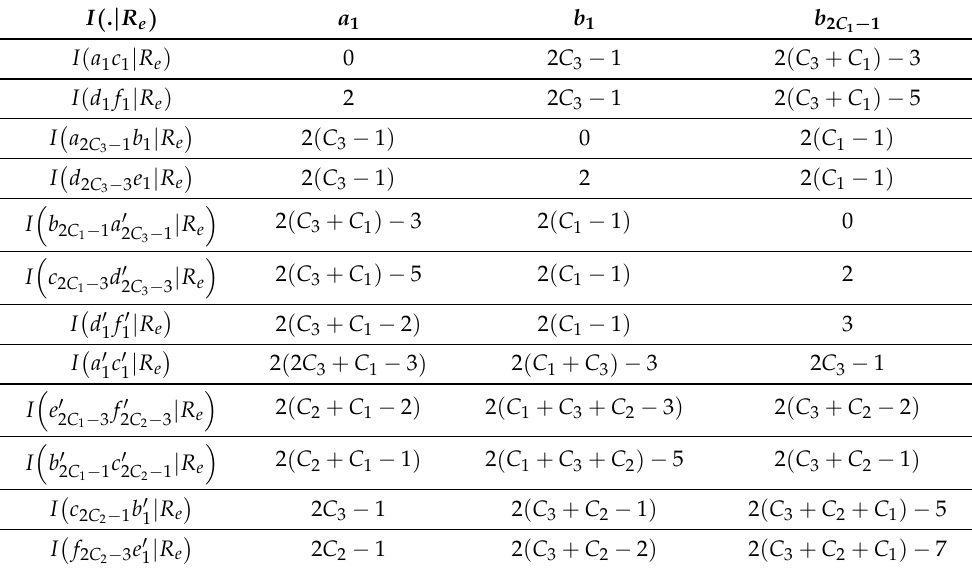
Table 1. Representation of edges with respect to resolving set R e